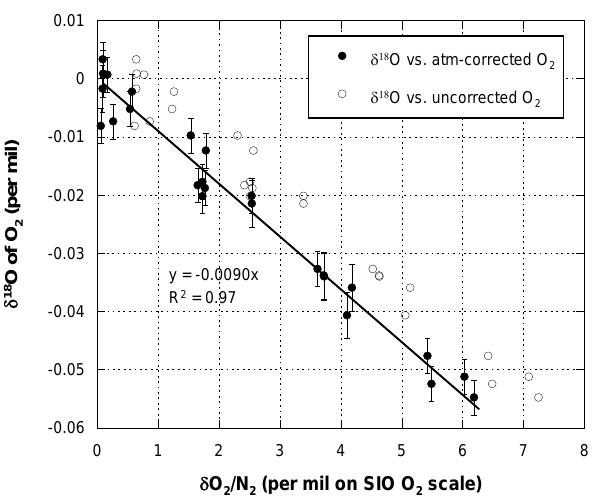
Fig. 6. Isotopic ratios of Ar as a function of Ar abundance in the lock-in zone. The absence of a trend in δ 40 Ar / 36 Ar suggests that the mechanisms that fractionate (diatomic) oxygen isotopes may not act on (monatomic) Ar isotopes. Only data from below 64 m are shown.